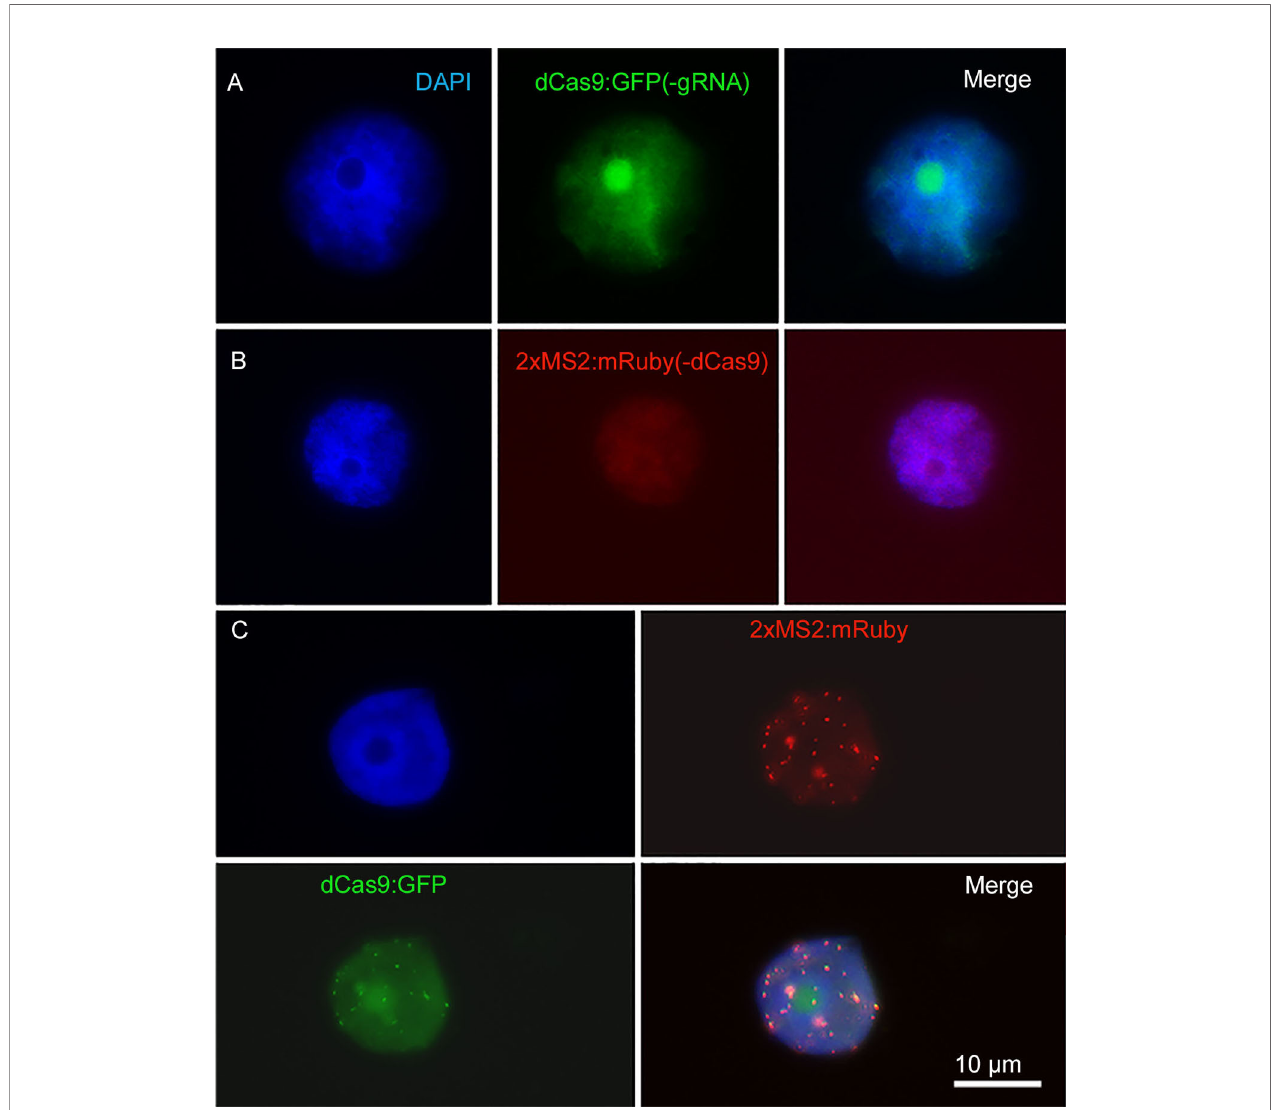
FIGURE 3 | Negative control with partial constructs carrying (A) dCas9:GFP without gRNA or (B) 2xMS2:3xmRuby targeting telomeres without dCas9. (C) Co- transformation of N. benthamiana leaves with both partial dCas9:GFP and 2xMS2:3xmRuby constructs resulted in labeling of telomeres, while no telomere-like signals were found after transformation with either partial construct (A, B) . Nuclei are counterstained with